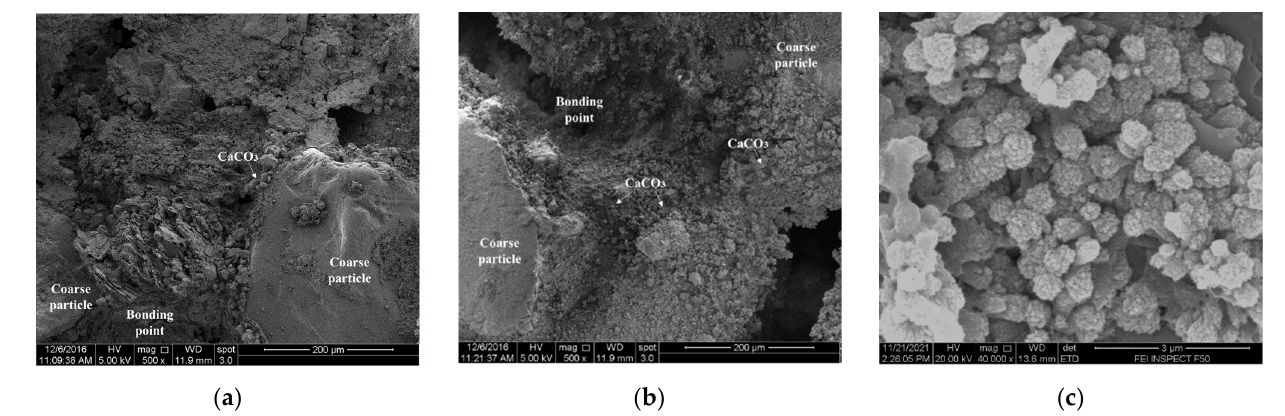
Figure 6. SEM images of samples treated with ( a ) the optimized medium (magnification = 500 × ), ( b ) C medium (magnification = 500 × ), and ( c ) optimized medium (magnification = 40,000 × ).